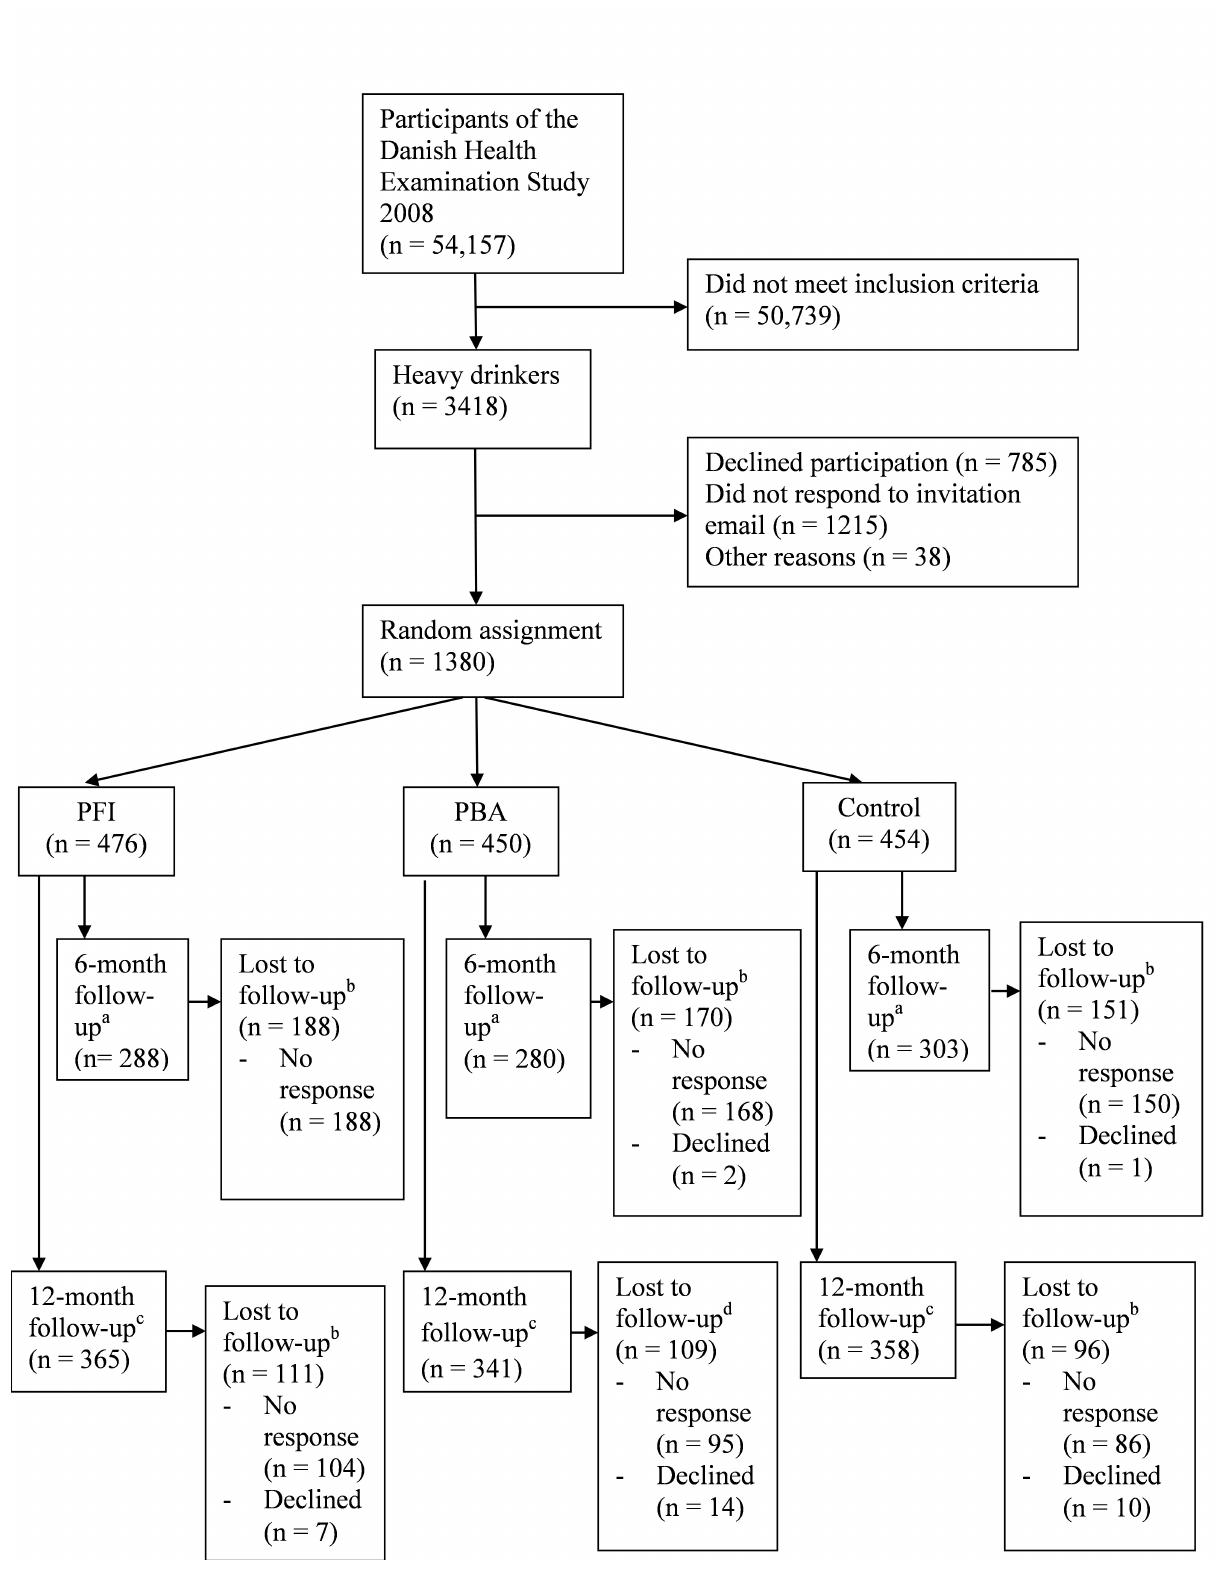
Figure 4. Flow of participants through the study. PBA = Internet-based personalized brief advice intervention, PFI = Internet-based brief personalized feedback intervention. a Follow-up took place by means of two emails. b No response and declined are subsets of lost to follow-up. c Follow-up took place by means of two emails and two letters.